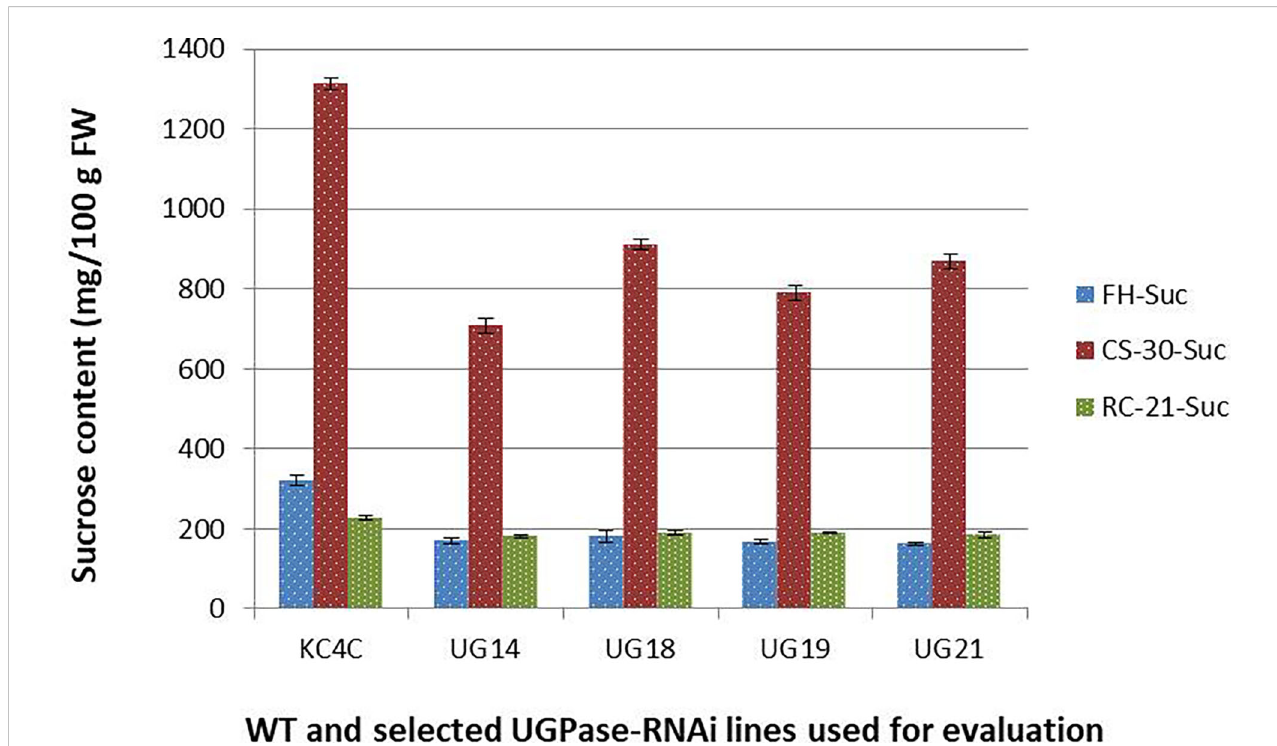
FIGURE 5 Sucrose content in the UGPase RNAi potato transgenic lines of KC4. KC4C, Kufri Chipsona-4 control; UG14, UG18, UG19, and UG21 are the four selected UGPase RNAi transgenic lines of KC4. FH, Fresh harvest; CS-30, cold stored for 30 days; RC-21, 21 days reconditioning at room temp after cold